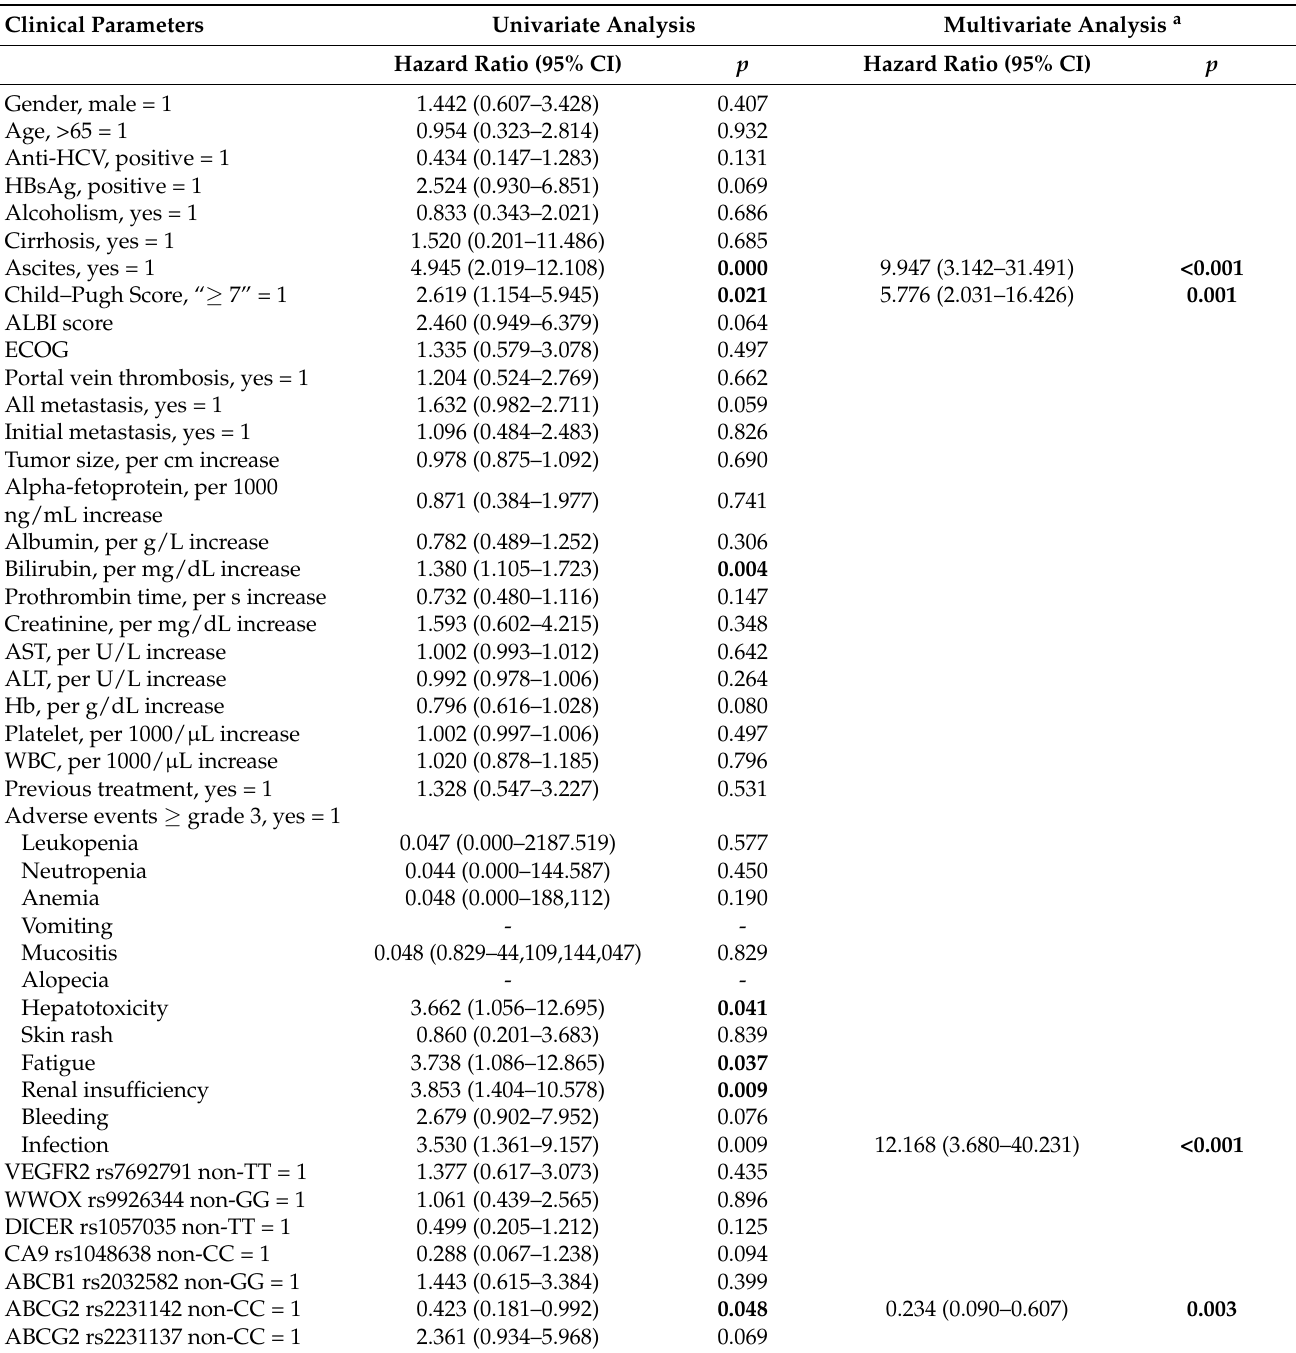
Table 3. Cox proportional hazard analysis for association between clinical factors and overall survival